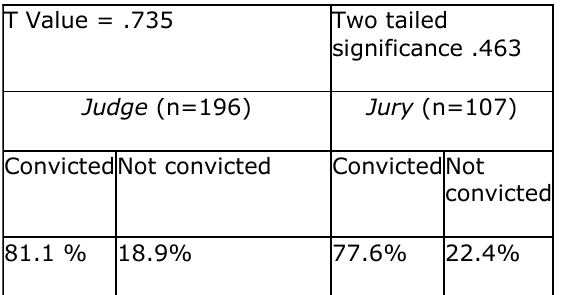
Table 2: Percentage of Celebrity Convictions by Adjudicator, 1998-2010 T Value = .735